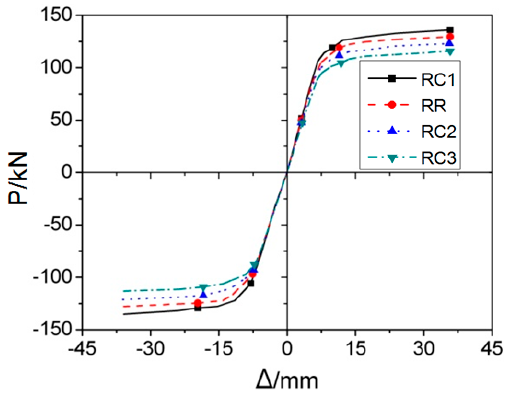
Figure 20. The skeleton curves of RC series FE models under cyclic loading.